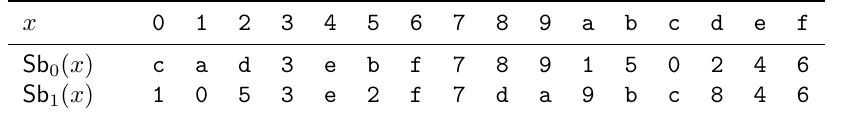
Table 1: Specifications of Sb 0 and Sb 1